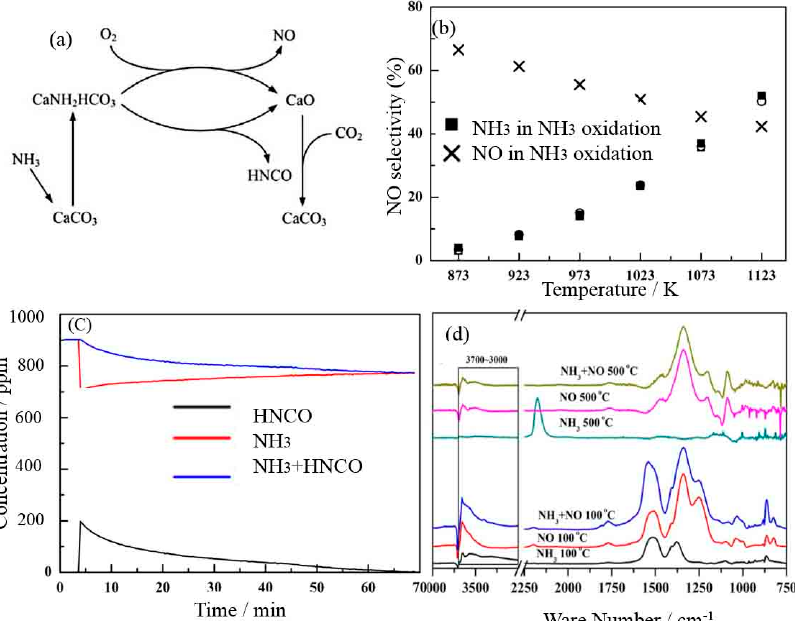
Figure 8. ( a ) Reaction mechanism of selective noncatalytic reduction (SNCR) on CaCO 3 surface, ( b ) NH 3 conversion and NO selectivity in different mixed gas, ( c ) FTIR analysis of CaCO 3 surface active species, and ( d ) in situ FTIR analysis of reaction intermediates at 500 °C [140,141]. Reproduced from Ref. [140], Copyright 2016, Elsevier; Reproduced from Ref. [141], Copyright 2015, Elsevier.